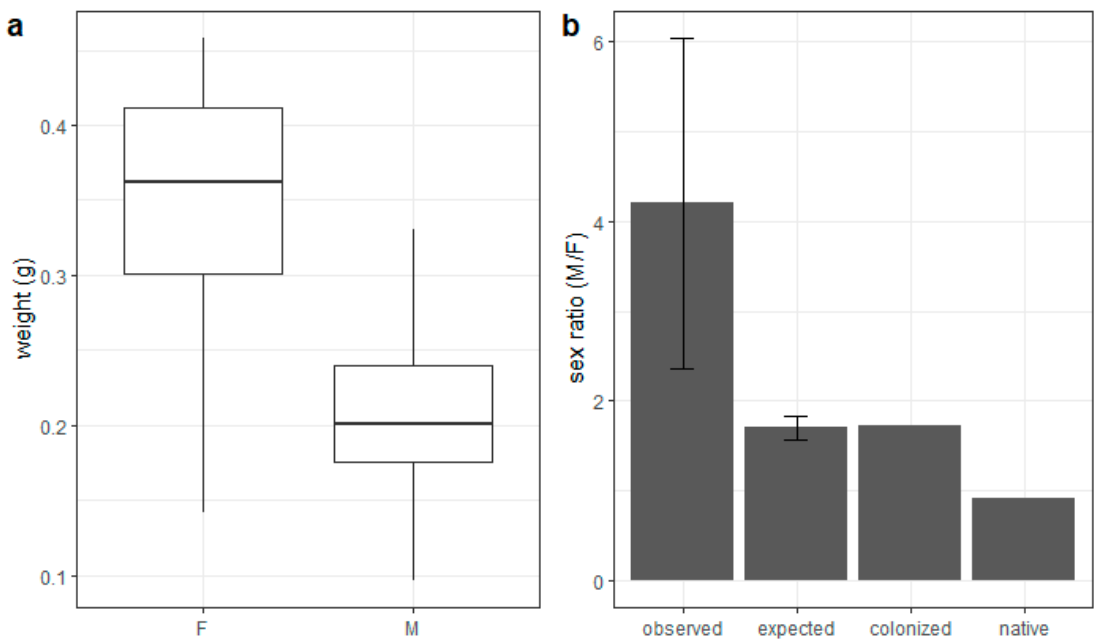
Figure 3. Progeny weight and sex ratio of M. sculpturalis. ( a ) Boxplot of female and male weights; ( b ) sex ratios (male/female) and standard error for observed nests, expected sex ratio according to Fischer’s sex allocation theory (see Section 2.3.1. for details) and sex ratio calculated using GBIF data, respectively in the colonized and native areas.